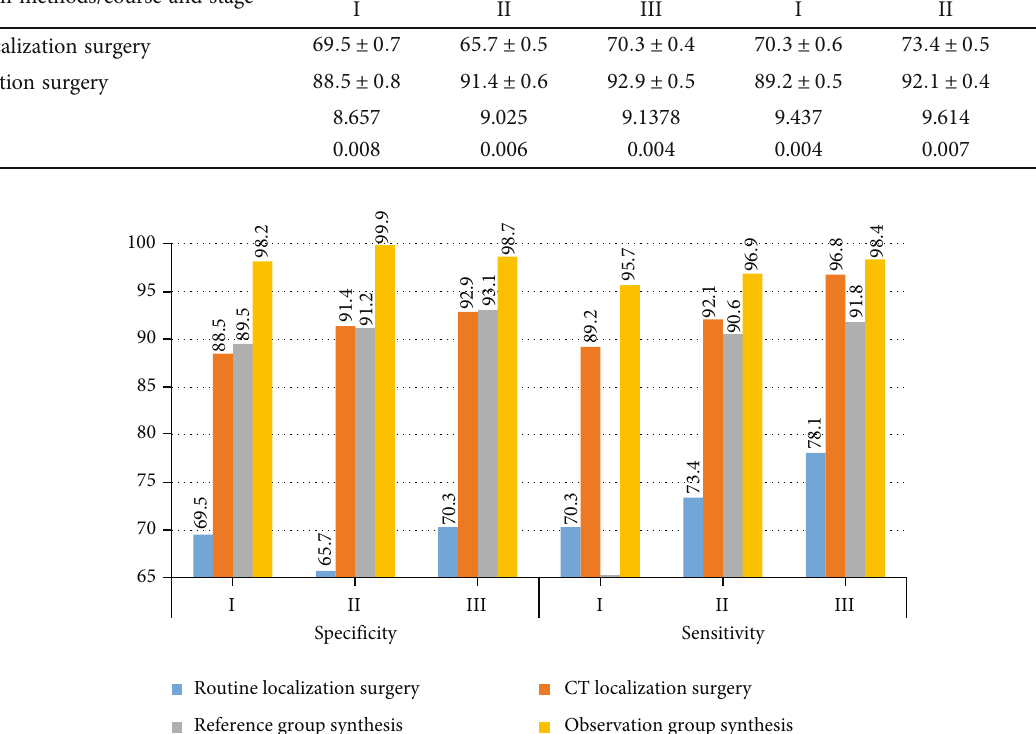
Table 2: operation methods of patients with pulmonary nodules (data source: self-statistics of the study). Examination methods/course and stage